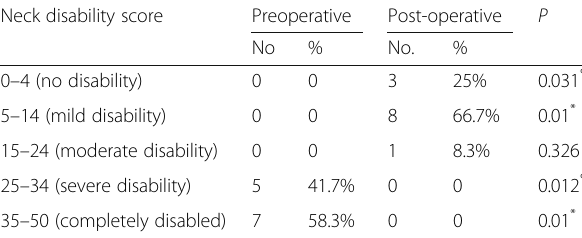
Table 2 Neck disability score pre- and post-operative in cases of the study Neck disability score Preoperative